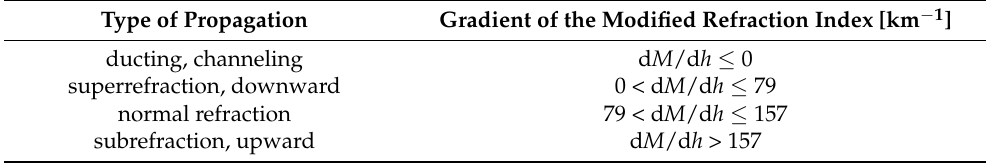
Table 1. Types of radio propagation